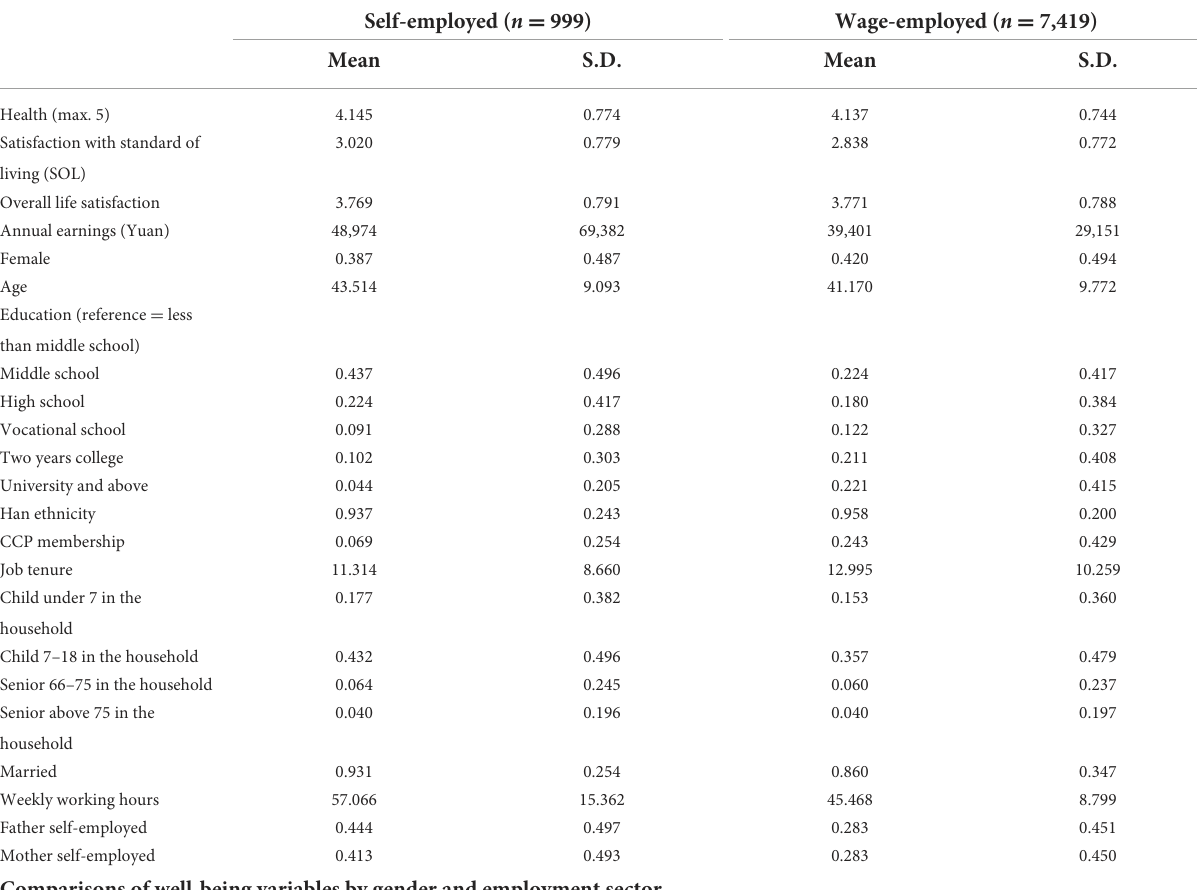
TABLE 1 Summary statistics and well-being by gender and employment